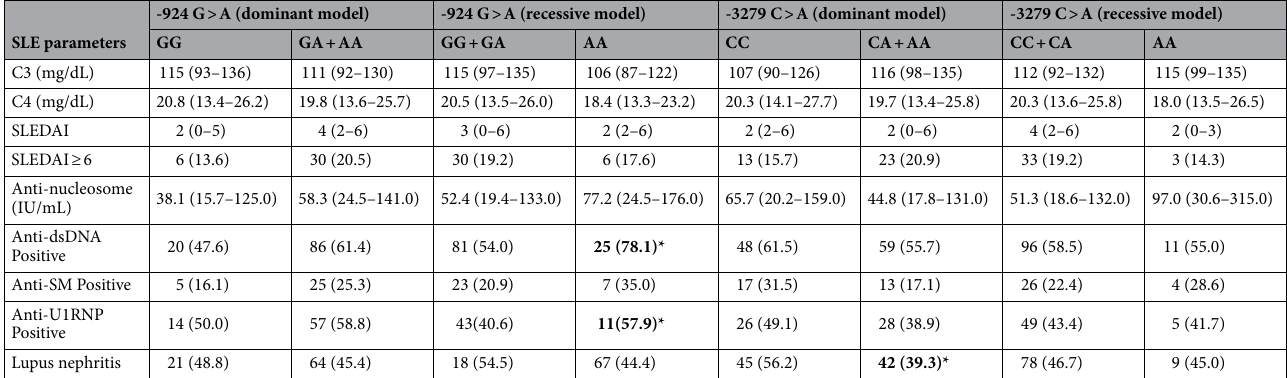
Table 4. Clinical and laboratory parameters of patients with systemic lupus erythematosus (SLE) according to FOXP3 -924 G > A (rs2232365) and -3279 C > A (rs3761548) genotypes in dominant and recessive models. Data were expressed by median and percentile (25–75) or absolute number (n) and percentage (%). * p < 0.05, adjusted by age, ethnicity, body mass index and treatment. C3: complement 3; C4: complement 4; SLEDAI: systemic lupus erythematosus disease activity index; Anti-dsDNA: anti-double-stranded DNA; Anti-SM; anti- Smith; Anti-U1RNP: anti-U1 ribonucleoprotein.